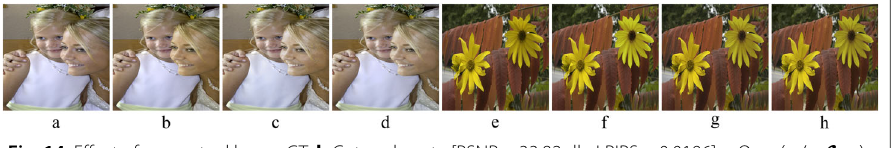
Fig. 14 Effect of perceptual loss. a GT. b Cut-and-paste [PSNR = 33.82 db, LPIPS = 0.0196]. c Ours (w/o L per ) [PSNR = 31.64 db, LPIPS = 0.0580]. d Ours [PSNR = 35.83 db, LPIPS = 0.0167]. e GT. f Cut-and-paste [PSNR = 31.66 db, LPIPS = 0.0100]. g Ours (w/o L per ) [PSNR = 34.33 db, LPIPS = 0.0464]. h Ours [PSNR = 36.37db, LPIPS = 0.009]